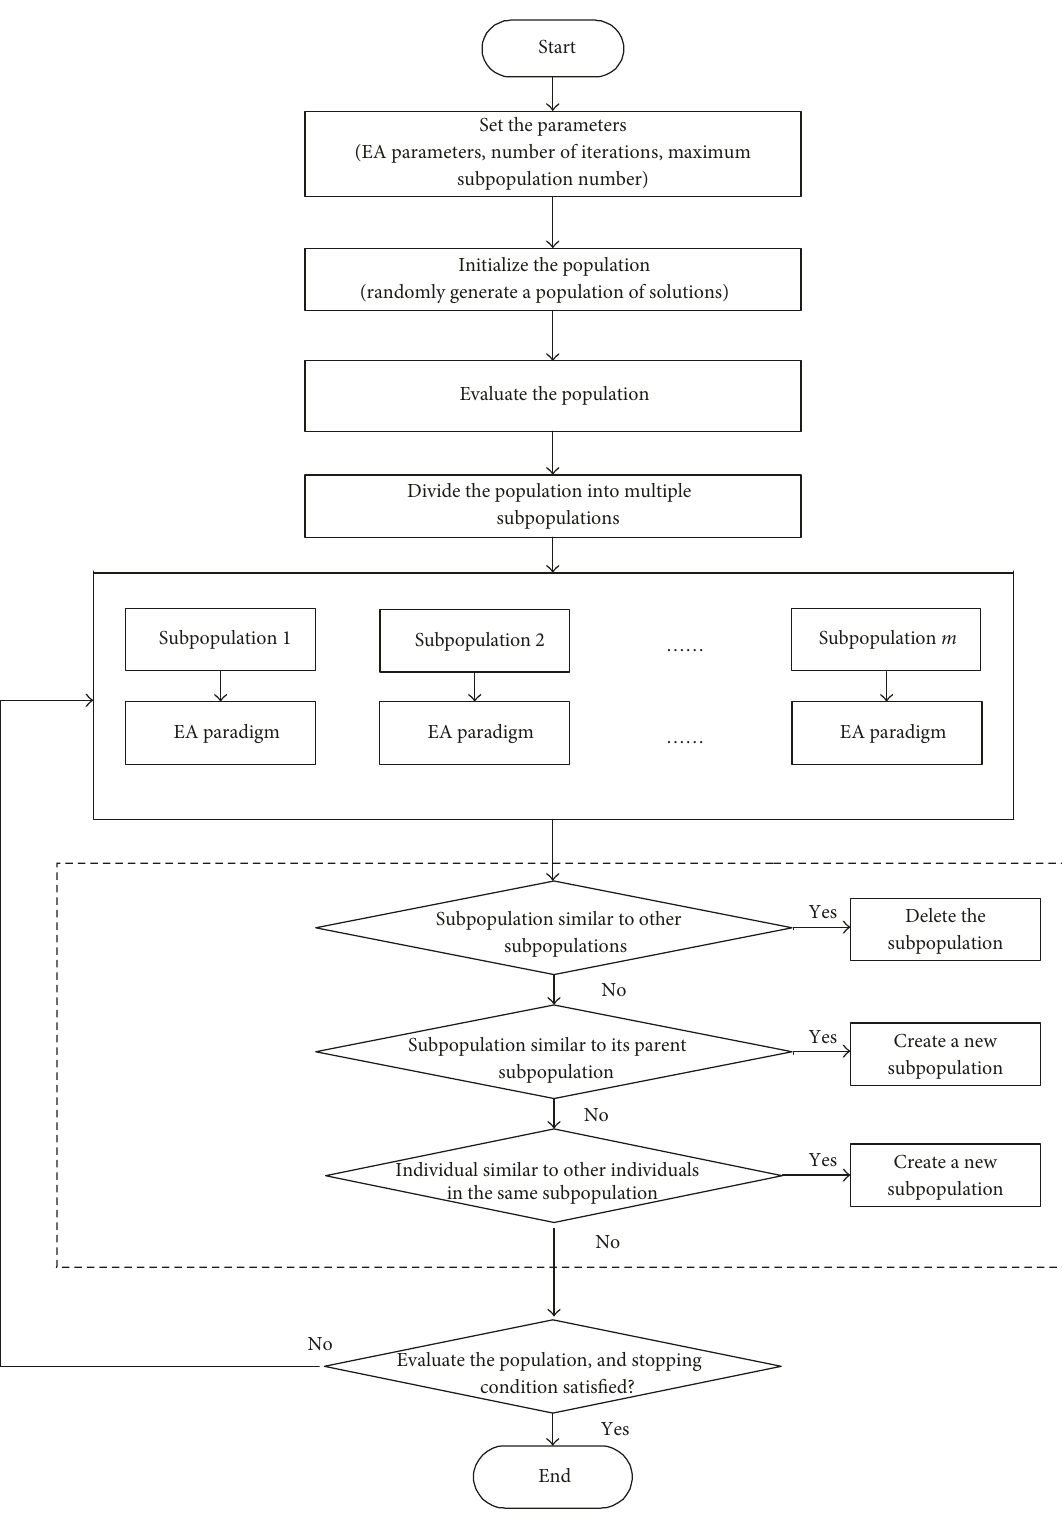
Figure 2: Flowchart of the proposed multipopulation